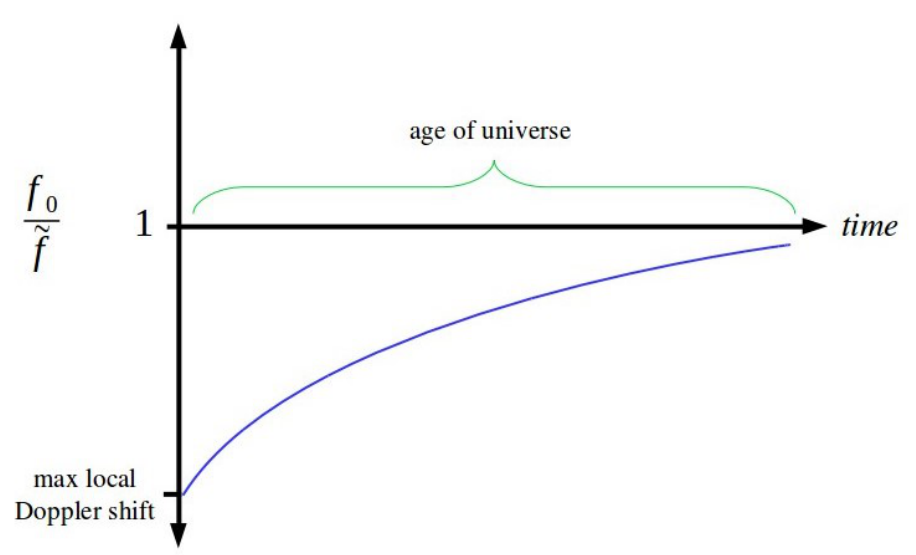
Figure 1. Schematic diagram of the bluing of Doppler redshift accruing from Hubble drag. This diagram shows the time evolution of the locally-observed Doppler shift of a receding beacon. This frequency shift at the beacon includes effects from time dilation, recession, and Hubble expansion. Hubble drag will slow the velocity relative to the cosmic rest frame, manifesting as a decrease in locally-observed Doppler